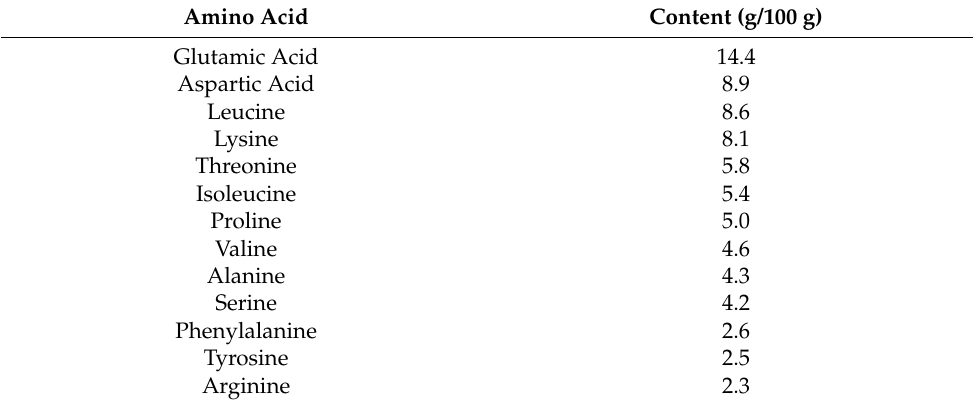
Table 1. Typical amino acid profile of whey hydrolysate peptides